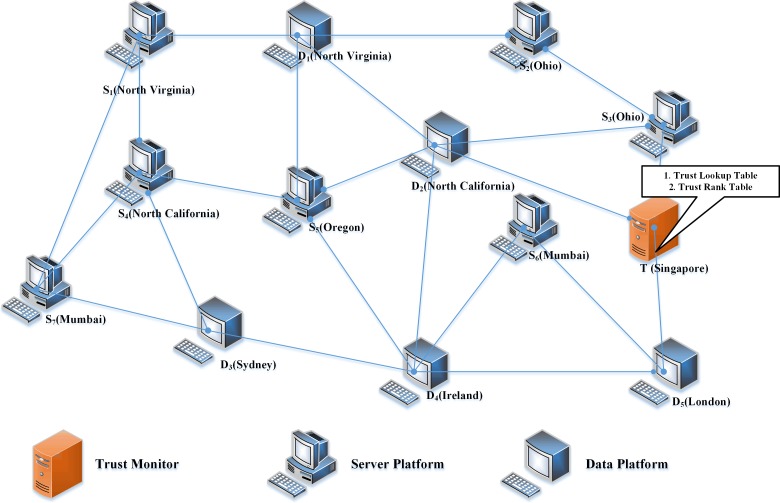
Experimental setup.